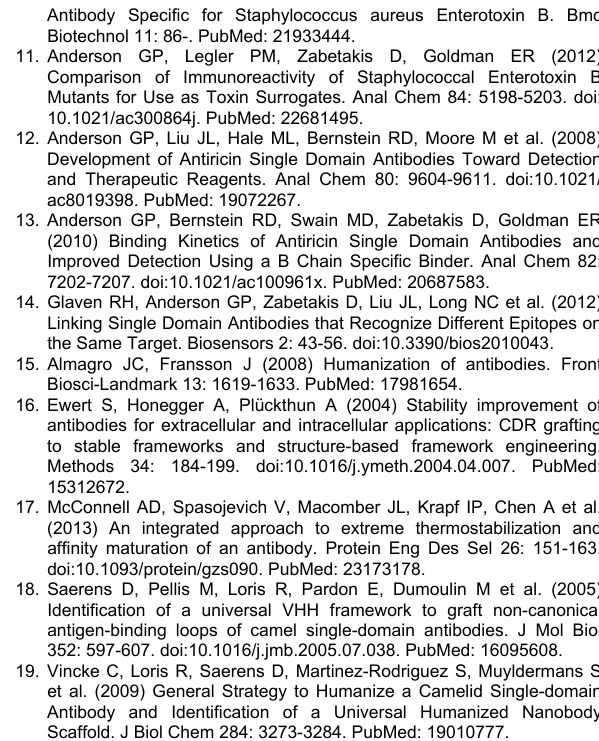
Figure S3. Circular dichroism spectrum of sdAb ADD showing an atypically flat curve. The spectrum of sdAb DAA is shown for comparison and reveals a typical sdAb spectrum with positive and negative CD regions between 210 nm and 230 nm, and a large positive peak below 210